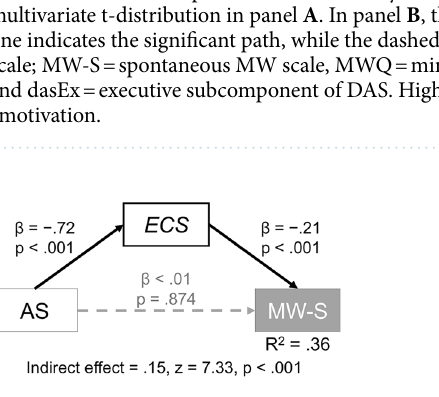
Figure 4. Mediation Analyses of the Relationship Between the Apathy Scale and Spontaneous Mind Wandering Scale. Note The ECS was the single mediator. AS = apathy scale; ECS = effortful control scale, MW-S = spontaneous MW